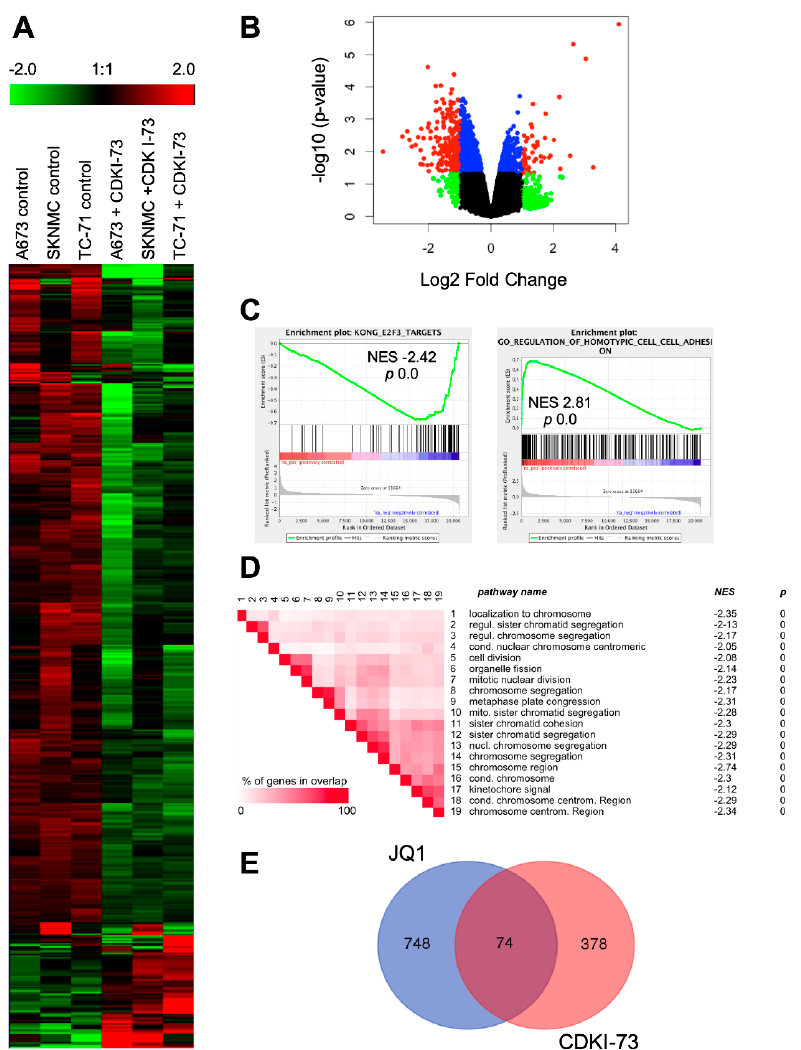
Figure 3. Expression profile of EwS cells after treatment with CDKI-73. ( A ) Heat map of 504 genes, 1.5-fold di ff erentially expressed in 3 di ff erent EwS lines A673, SKNMC, and TC-71 are shown. Each column represents 1 individual array. Microarray data with their normalized fluorescent signal intensities were used (robust multichip average (RMA), see Materials and Methods; GSE119546). Cells were treated with DMSO or CDKI-73 for 8 h, collected, and then analyzed. ( B ) Volcano plot for CDKI-73 treated against solvent control EwS cell lines (A673, SKNMC, TC-71), showing the significance p -value ( − log 10 ) plotted over fold change (log 2). The color coding is as follows: red, genes with a p -value < 0.05 and an absolute log FC > 1; blue, genes obtaining a p -value < 0.05 and an absolute log FC ≤ 1; green, genes with a p -value ≥ 0.05 and an absolute log FC > 1; and black, genes with a p -value ≥ 0.05 and an absolute log FC ≤ 1. ( C ) Gene set enrichment analysis (GSEA) enrichment plots of down- and up-regulated gene sets after CDKI-73 treatment. NES: normalized enrichment score. GSEA: http: // www.broadinstitute.org / gsea / index.jsp ( D ) GSEA leading-edge analysis of identified gene sets up- or down-regulated after CDKI-73 treatment (C5_all, GO gene sets), respectively. Set-to-set analysis shows a correlation between CDKI-73 treatment and down-regulation of gene sets important for chromosomal regulation. ( E ) Shared genes di ff erentially expressed after either CDKI-73 or JQ1 treatment in di ff erent EwS lines (see [18]; GSE72673), respectively. For Venn diagram, genes ± 1.5-fold di ff erentially expressed were selected for the analysis (http: // bioinformatics.psb.ugent.be / webtools / Venn /